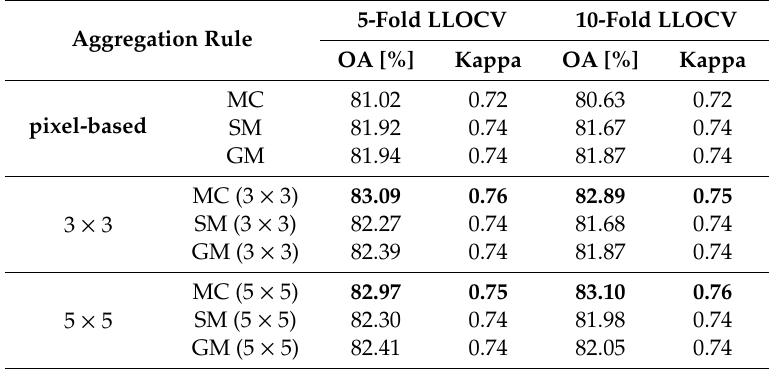
Table 3. Validation metrics obtained after 5-fold and 10-fold leave-location out